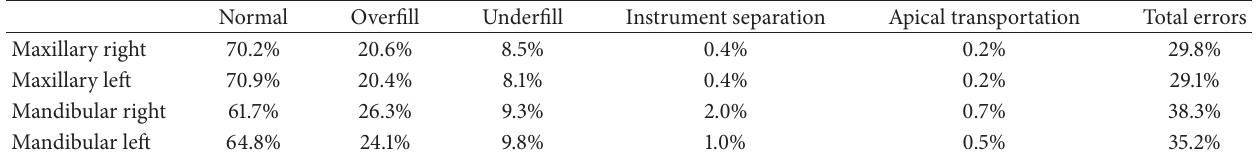
Table 2: Distribution of errors in right and left maxilla and